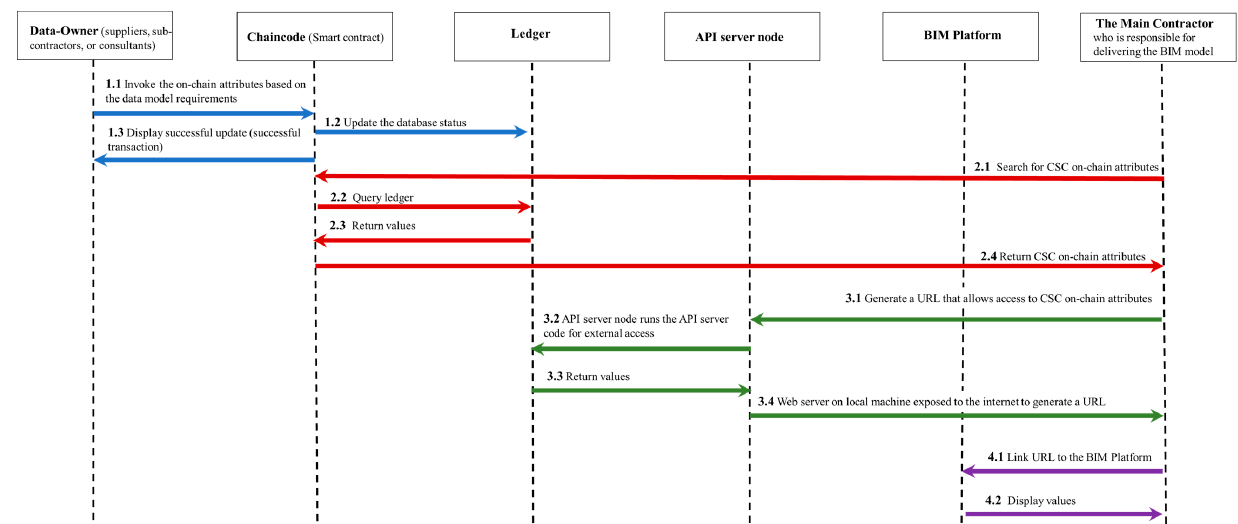
Figure 5. The process sequence for a successful transaction in the